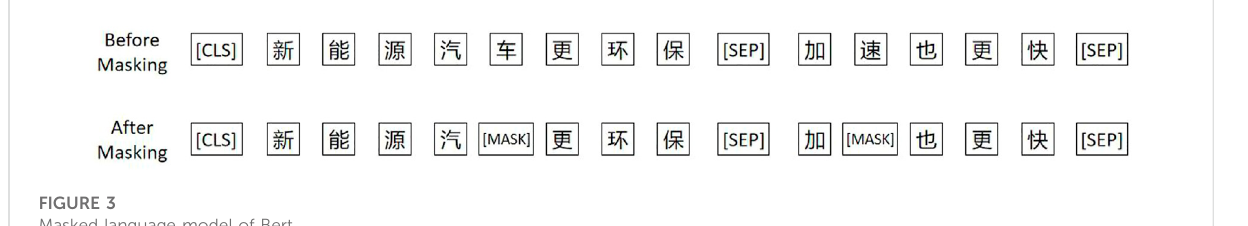
FIGURE 3 Masked language model of Bert.